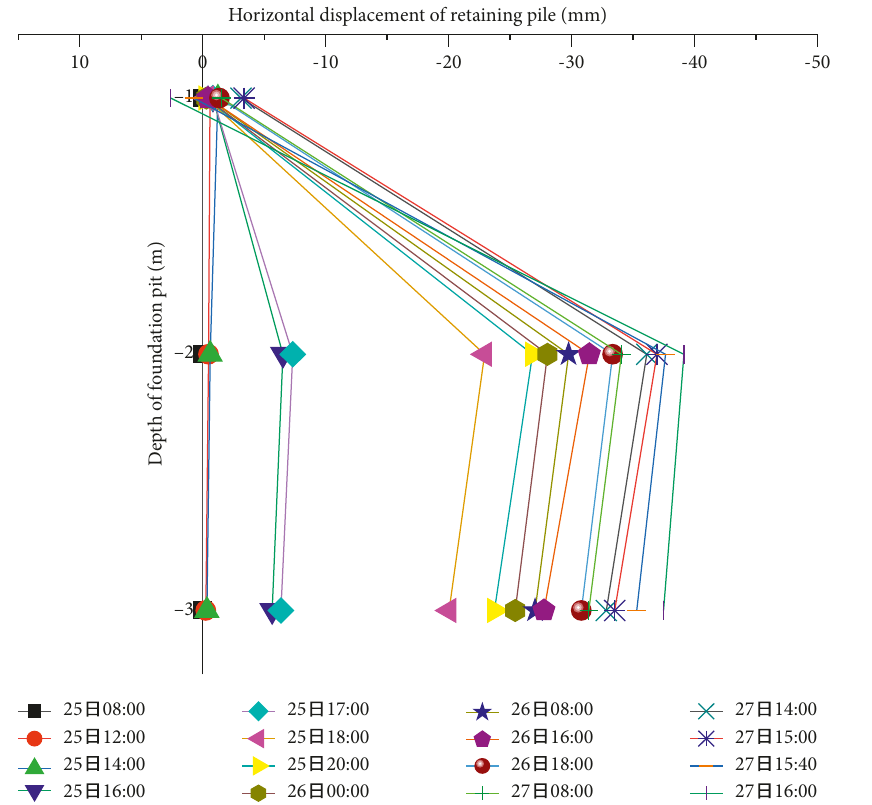
Figure 9: Lateral displacement of steel pipe pile with rigid